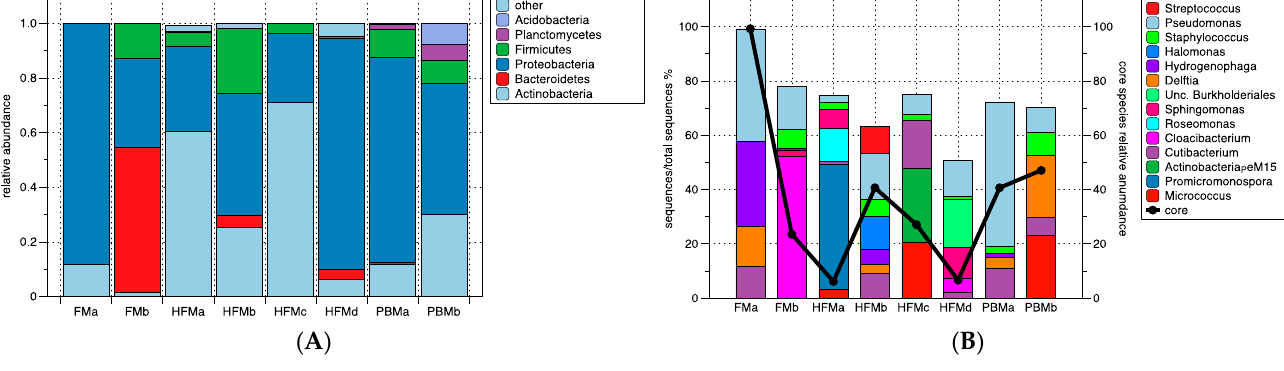
Figure 7. ( A ) Relative abundances of different bacterial phyla in fish fed the FM, PBM50 and HFM50 diets; ( B ) Relative abundances of abundant (>10%; left axis) and shared (between treatments) OTUs (right y -axis) in fish fed the FM, PBM50 and HFM50 diets.